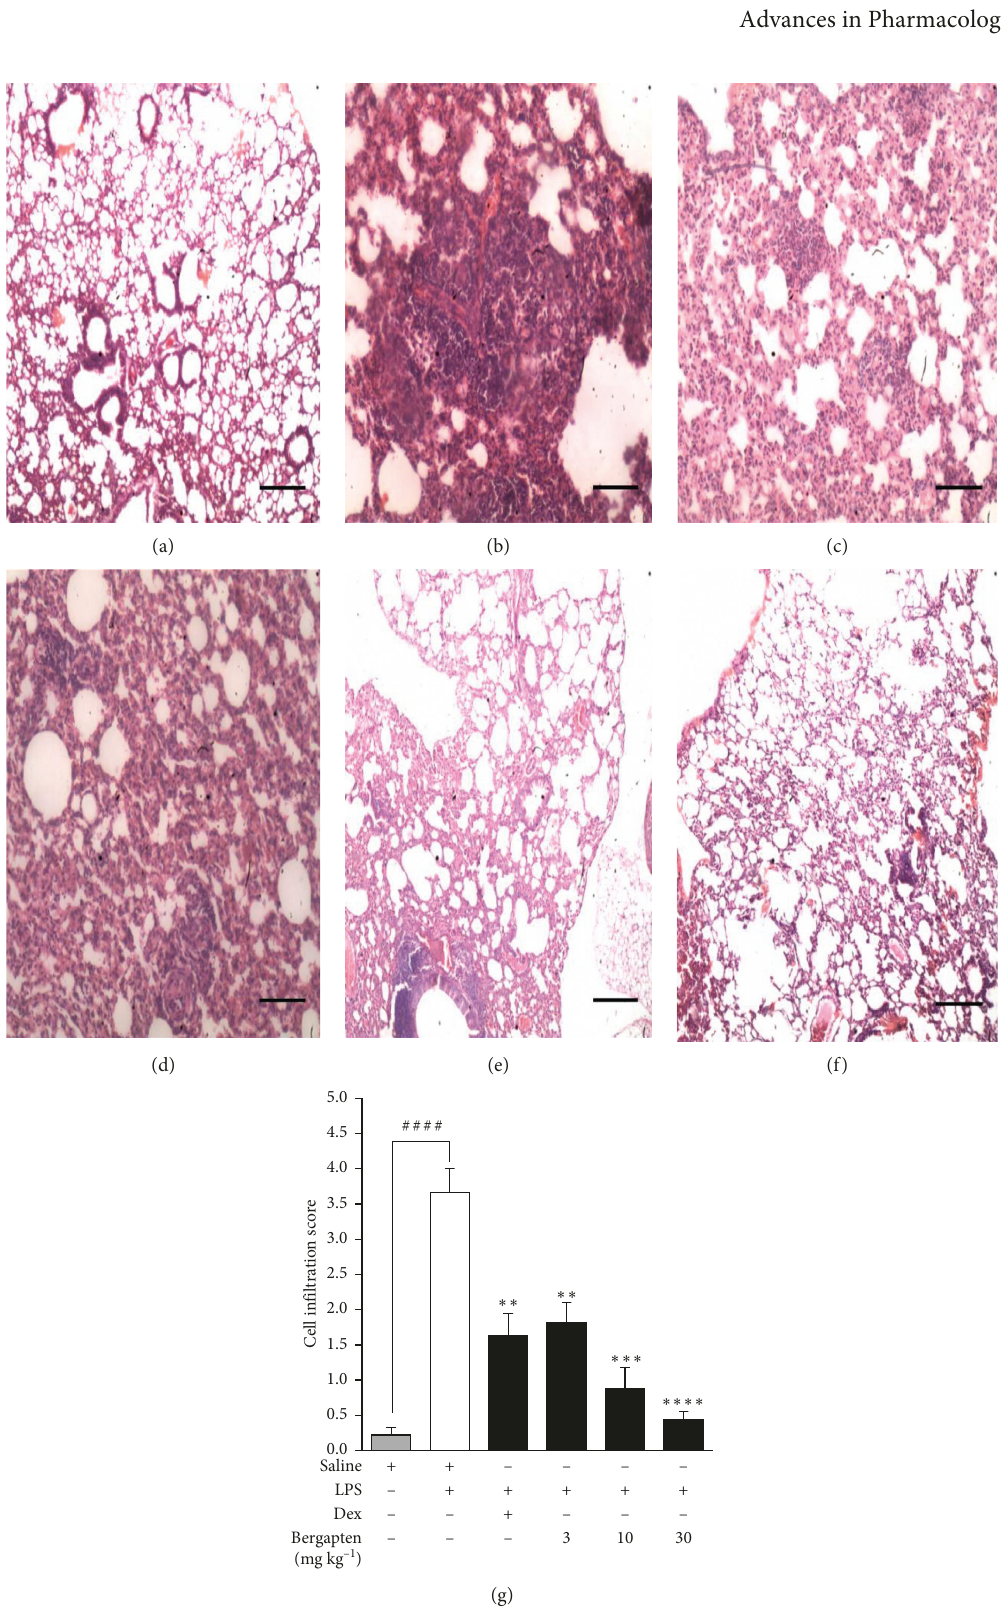
Figure 4: Effect of bergapten on lung damage in LPS-induced pulmonary inflammation. C57BL/6 mice were grouped and treated as na¨ıve control, saline 10ml kg − 1 (a), disease control, saline 10ml kg − 1 (b), dexamethasone 10mg kg − 1 (c), or bergapten 3, 10, and 30mg kg − 1